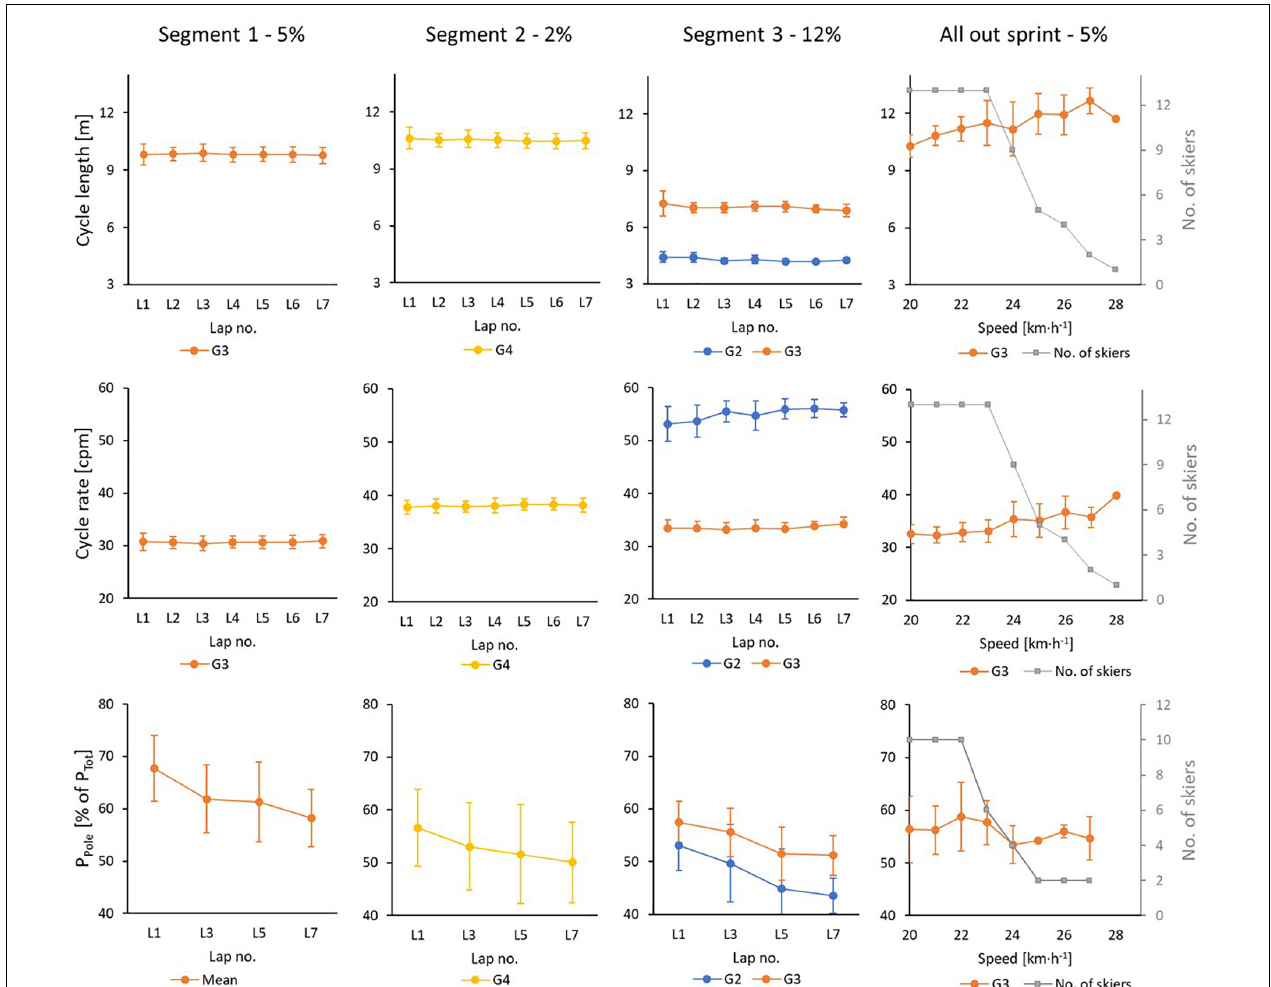
FIGURE 4 | Cycle length, cycle rate [in cycles per minute (cpm)] and body-mass normalized poling power (in %-age of mean cycle power) for the 13 skiers during a 21-min initial part with seven 3-min laps (L) where each contains 4 segments (with three of these analyzed here), followed by an all-out incremental sprint (AOS) with gradually increased speed each 15 s until exhaustion. In AOS the skiers are gradually stopping due to exhaustion, the number of remaining skiers is showed in gray color on the right